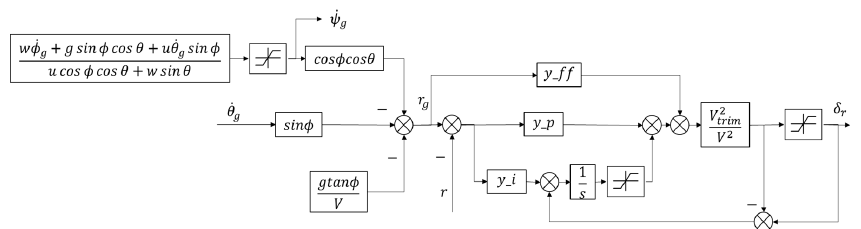
Figure B2. Roll angle control structure.